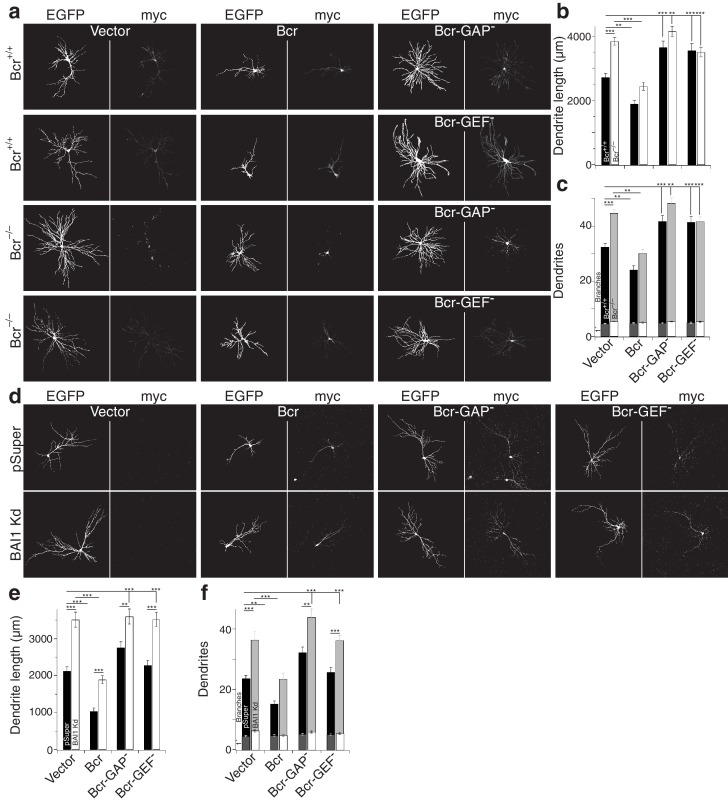
Both the RhoA-GEF and Rac1-GAP functions of Bcr are required for dendrite growth arrest.(a) Representative images of mouse neurons with the indicated genotype expressing EGFP, pSuper or shRNA against Adgrb1, and empty vector (Vector), wild-type Bcr (Bcr), GAP-dead Bcr (Bcr-GAP–), or GEF-dead Bcr (Bcr-GEF–). All cells within a row were cultured from the same individual mouse. (b) Summary data of dendrite length. (c) Summary data for dendrite numbers and branches. Total number of neurons: 147 for Bcr+/+ Vector, 82 for Bcr+/+ Bcr, 69 Bcr+/+ Bcr-GAP–, 69 Bcr+/+-GEF–, 177 for Bcr–/– Vector, 99 for Bcr–/– Bcr, 75 Bcr–/– Bcr-GAP–, and 109 for Bcr–/– Bcr-GEF– (N = 6–12). (d) Representative images of rat neurons expressing EGFP and pSuper or BAI1 Kd and the vectors as described in panel a. (e) Summary data of dendrite length. (f) Summary data of dendrite number and branches. Total number of neurons: 52 for pSuper Vector, 52 for pSuper Bcr, 37 pSuper Bcr-GAP–, 60 for pSuper Bcr-GEF–, 34 for BAI1 Kd Vector, 43 BAI1 Kd Bcr, 33 BAI1 Kd Bcr-GAP–, and 47 BAI1 Kd Bcr-GEF– (N = 5). Data are represented ± s.e.m. (***p<0.0001, **p<0.01, *p<0.05) Detailed statistics are found sin Figure 8—source data 1.10.7554/eLife.47566.056Figure 8—source data 1.Statistical summary for Figure 8: ANOVA and key Tukey post-hoc tests and N and n values for Figure 8b,c,e,f.10.7554/eLife.47566.055Figure 8—source data 2.Individual arbor parameters for mouse and rat neurons expressing different forms of Bcr Figure 8B,C,E,F.